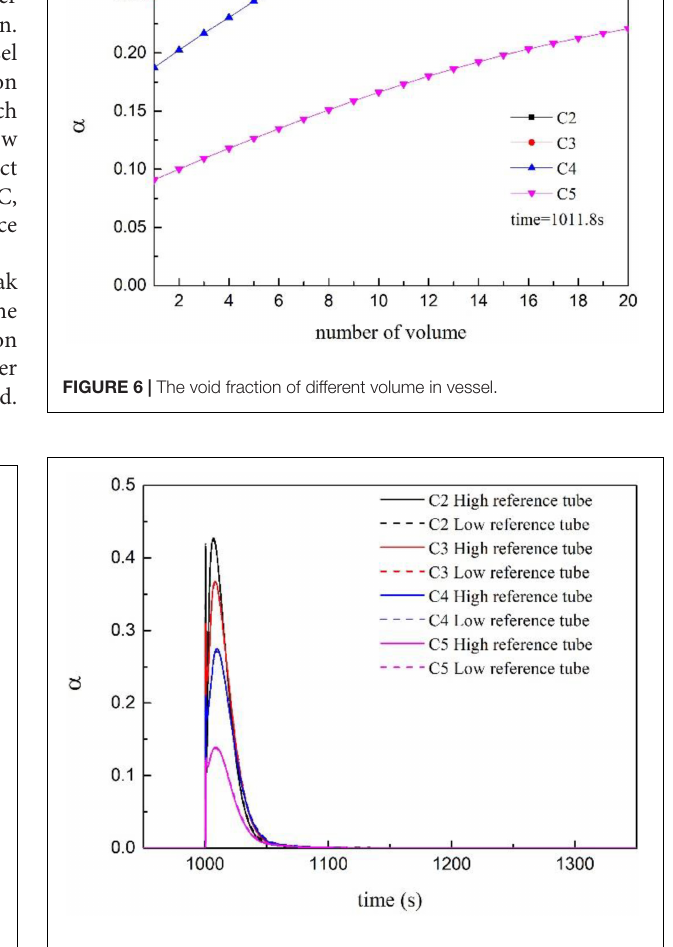
FIGURE 7 | Void fraction at the bottom of the reference